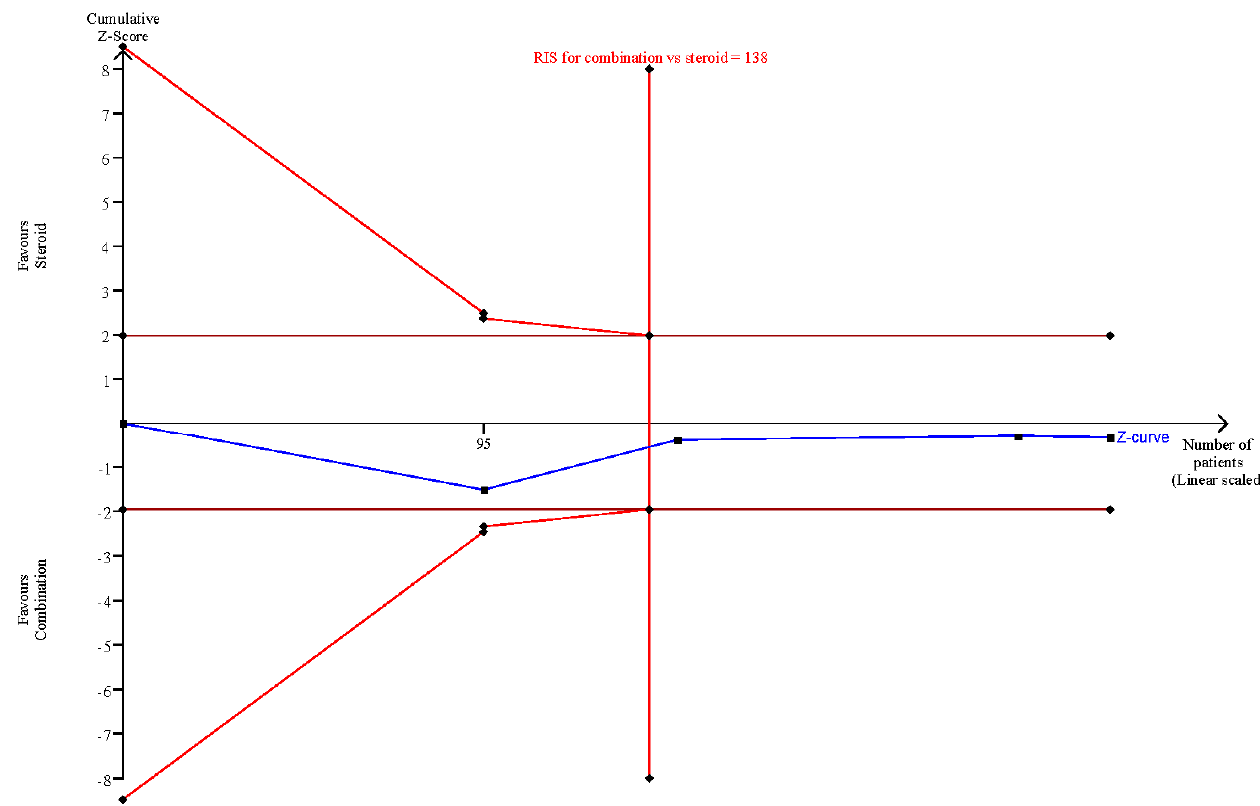
Figure 6. TSA comparing steroids alone and combination